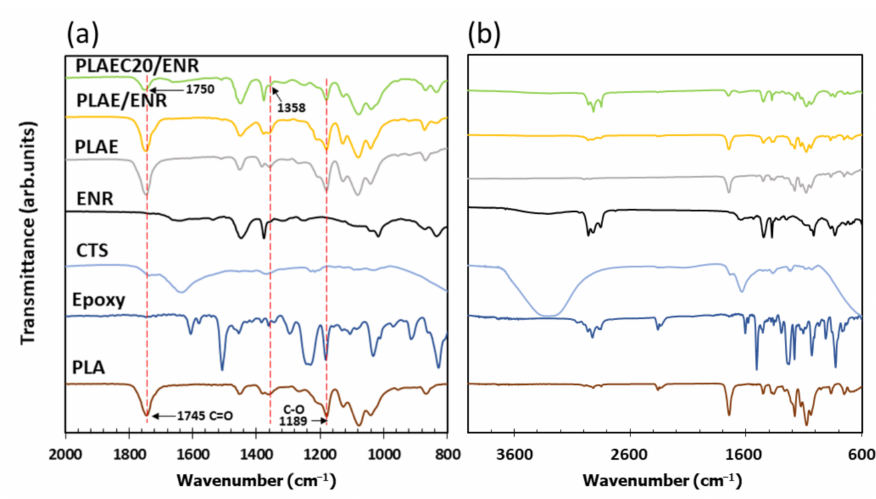
Figure 1. FTIR spectra of PLA, epoxy, CTS, ENR, PLAE, PLAE/ENR, and PLAEC20/ENR at